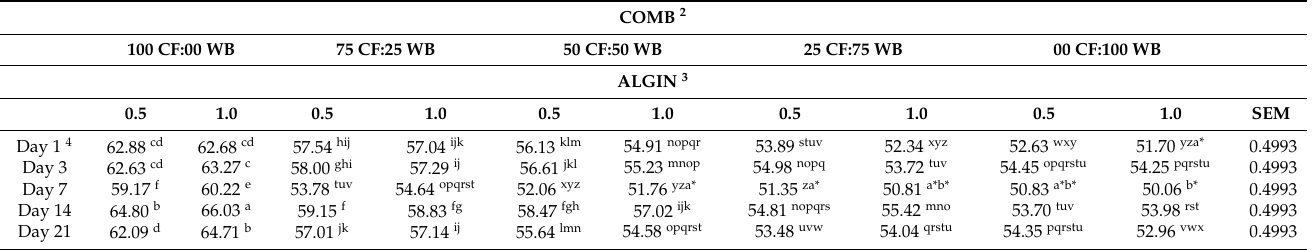
Table 2. Interactive effect of COMB × ALGIN × DAY on instrumental fresh color lightness (L*) 1 of fresh pet food formulations during a simulated retail